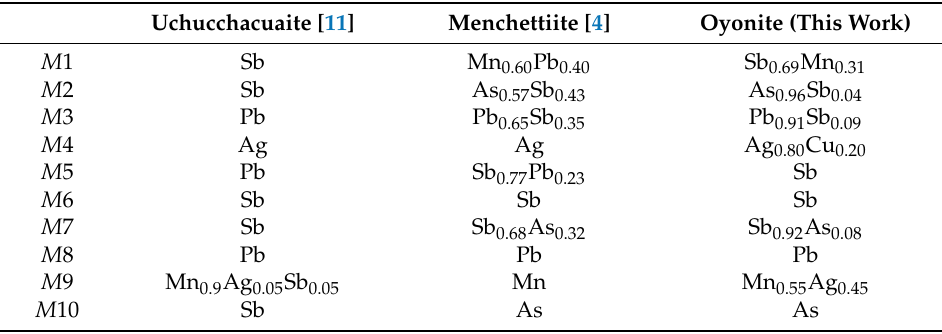
Table 7. Summary of site occupancies in Mn-bearing ramdohrite-type